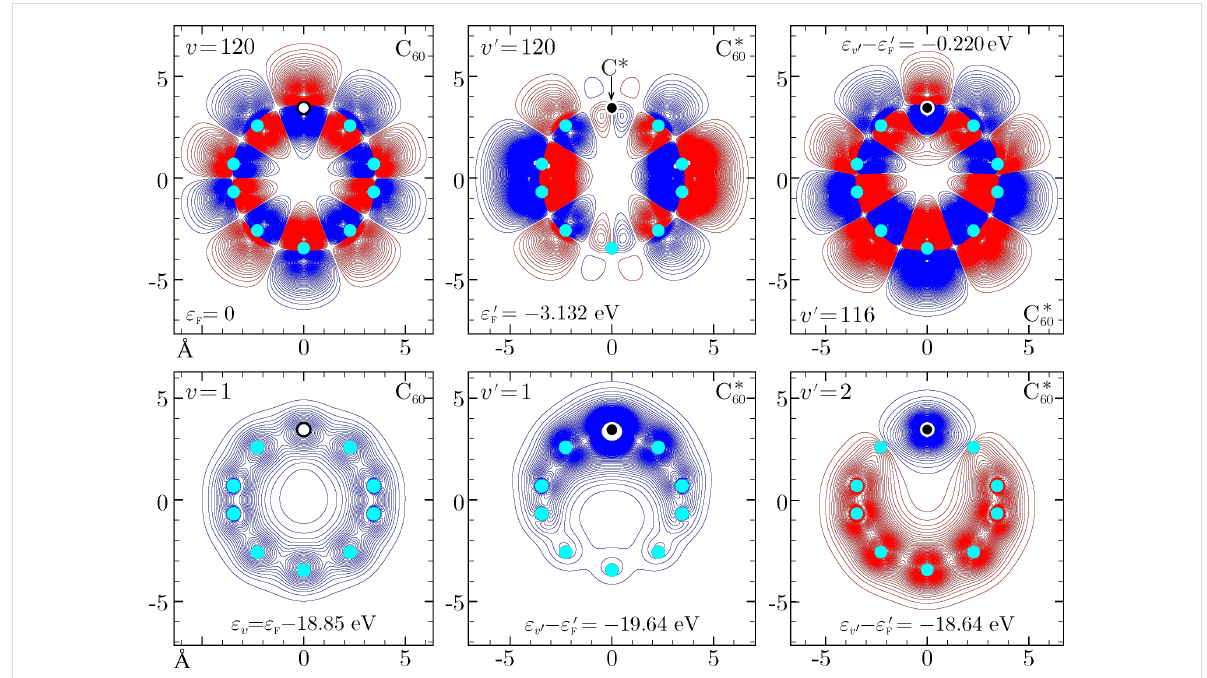
Figure 2: Lowest and highest occupied valence states for the neutral fullerene molecule (C 60 ) and corresponding valence states in the ionized fullerene molecule ( ). The sudden switching mechanism leads most of the content of the unperturbed Fermi state to be found in a state lying about 0.22 eV below the perturbed Fermi level. On the other hand, the lowest- energy unperturbed valence state gets mainly mixed with the first two occupied perturbed valence states (see also Table